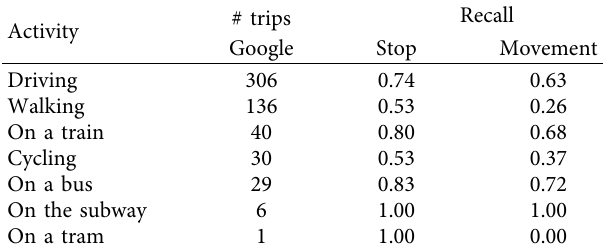
Table 5: Recall achieved for different activities and trip extraction methods, that is, the share of Google location history trips with a matching cellular network trip. Count shows the total number of Google trips of the activity in the dataset.